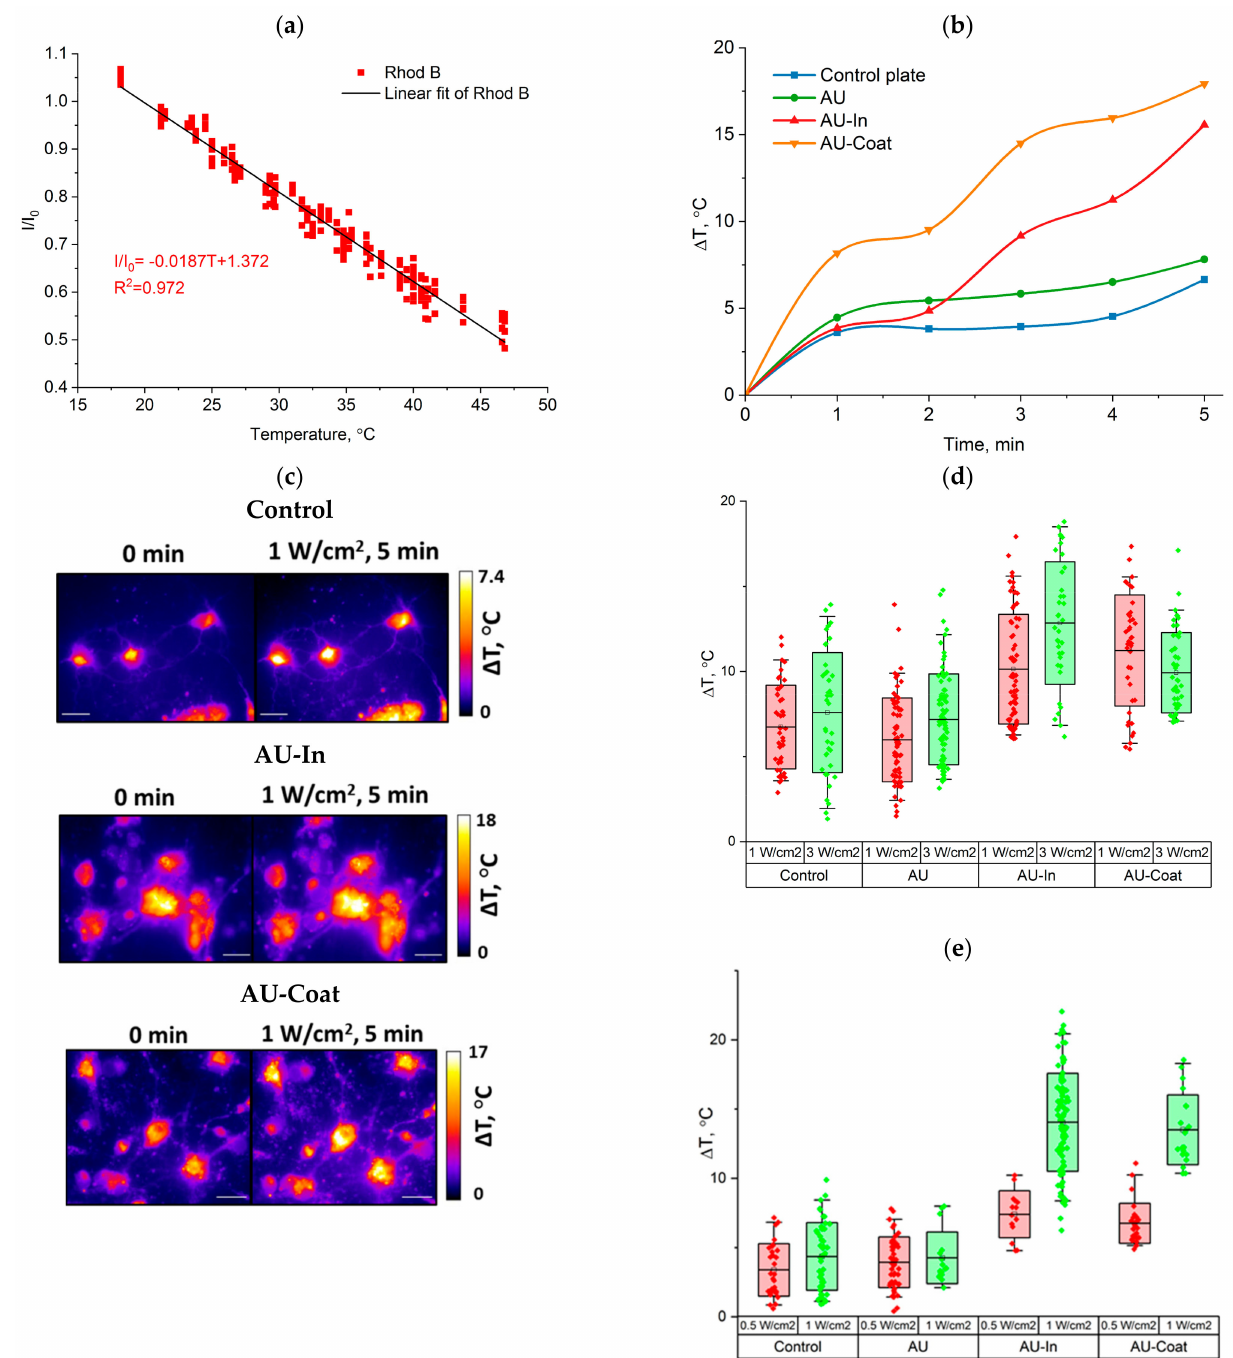
Figure 5. Analysis of intracellular temperature dynamics in rat hippocampal neuron during NIR stimulation. Temperature-dependent changes of normalized fluorescence intensity (I/I0, I0 is flu- orescent intensity at 20 ◦ C) of Rhod B inside the cells ( a ). Representative time courses of ∆ T ( ◦ C) during NIR stimulation ( b ). Representative thermal changes in neurons before (0 min) and after 5 min of NIR stimulation. ∆ T is represented in pseudo-colors. Scale bar—20 µ m. ( c ). Temperature changes ( ∆ T) during NIR stimulation (1 and 3.0 W/cm 2 for 5 min) in rat hippocampal neurons ( d ) and neuroblastoma cells ( e ), growing on different